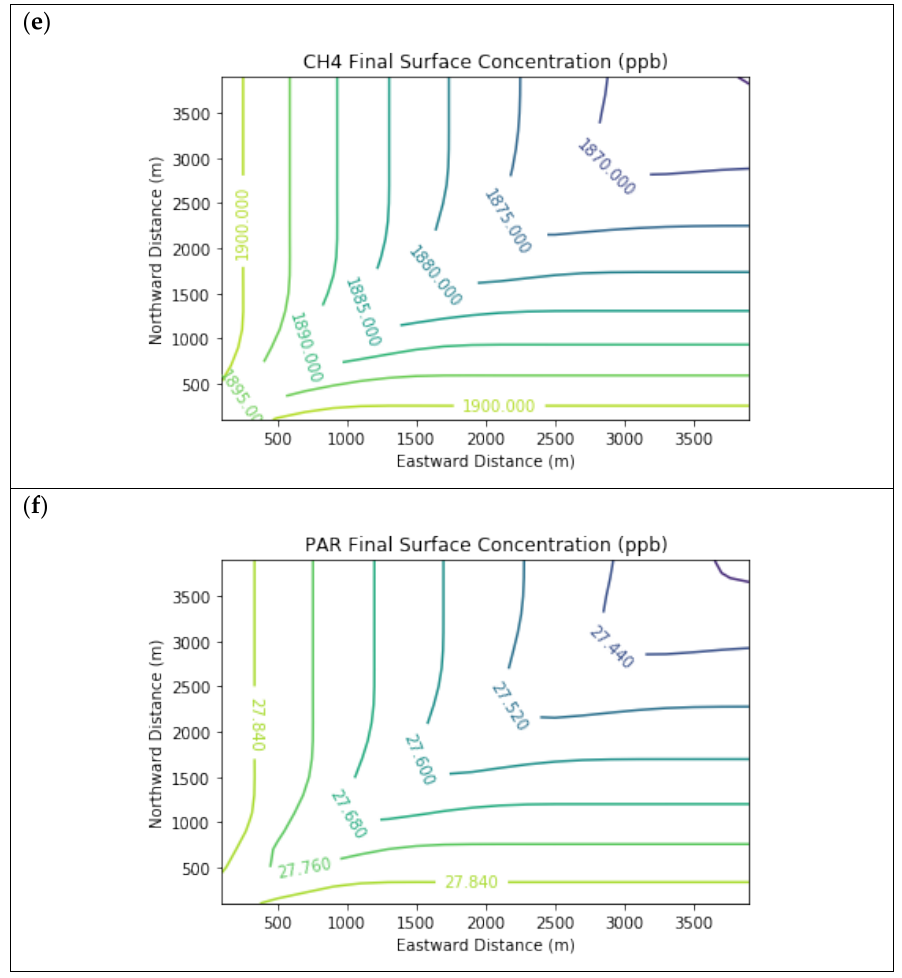
Figure 3. Near Source: Baseline Scenario . Final surface concentrations of ( a ) NO, ( b ) NO 2 , ( c ) O 3 , ( d ) HCHO, ( e ) CH 4 , and ( f ) PAR at the end of the 3 h simulation in the Baseline scenario for the 4 km × 4 km domain.